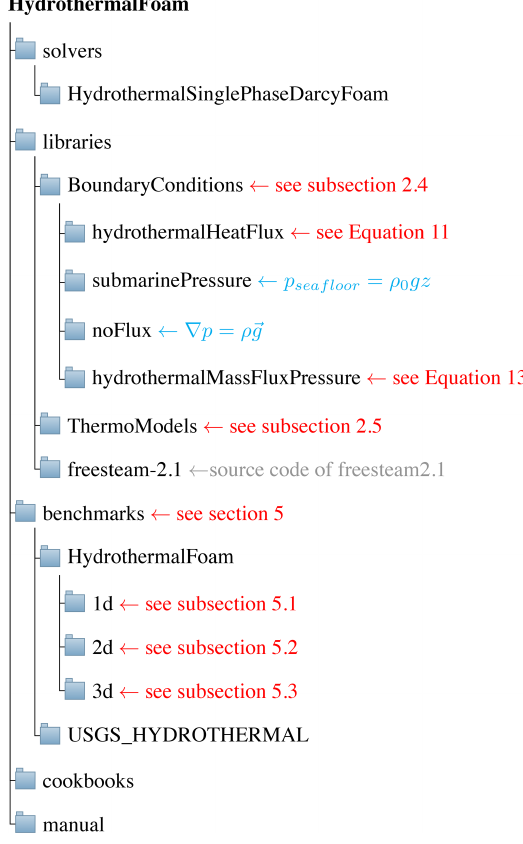
Figure 3. Structure and components of the HydrothermalFoam tool-